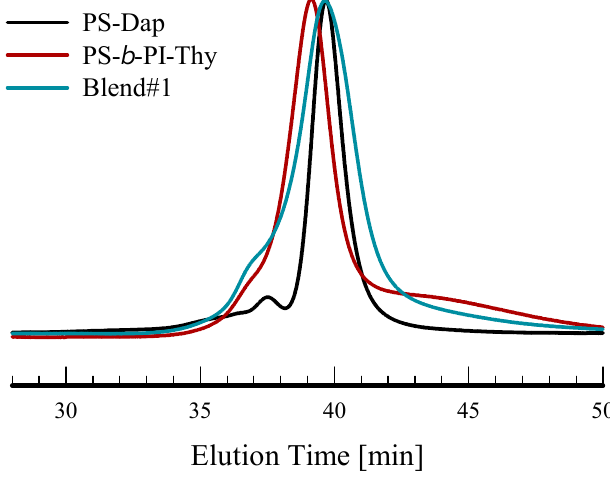
Figure 11. SEC traces of the samples PS ‐ Dap, PS ‐ b ‐ PI ‐ Thy, and Blend #1.